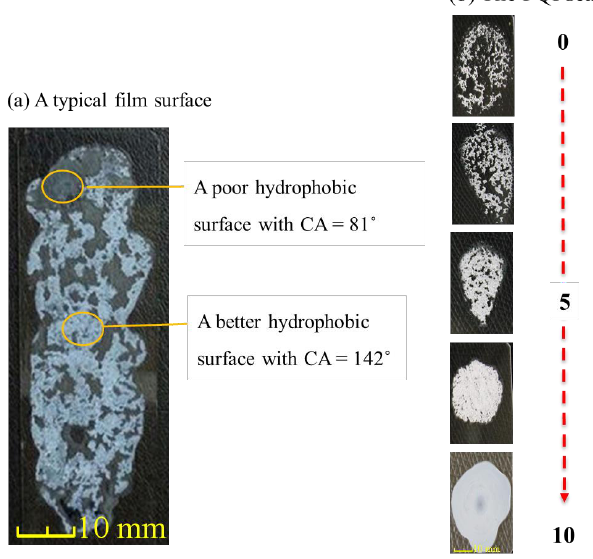
Figure 2. Film surface example, where ( a ) a typical film surface for sol aging time of >4 h, and ( b ) 0– Figure 2. Filmsurfaceexample, where( a )atypicalfilmsurfaceforsolagingtimeof > 4h, and( b )0–10 scales 10 scales of film quality index (FQI). of film quality index